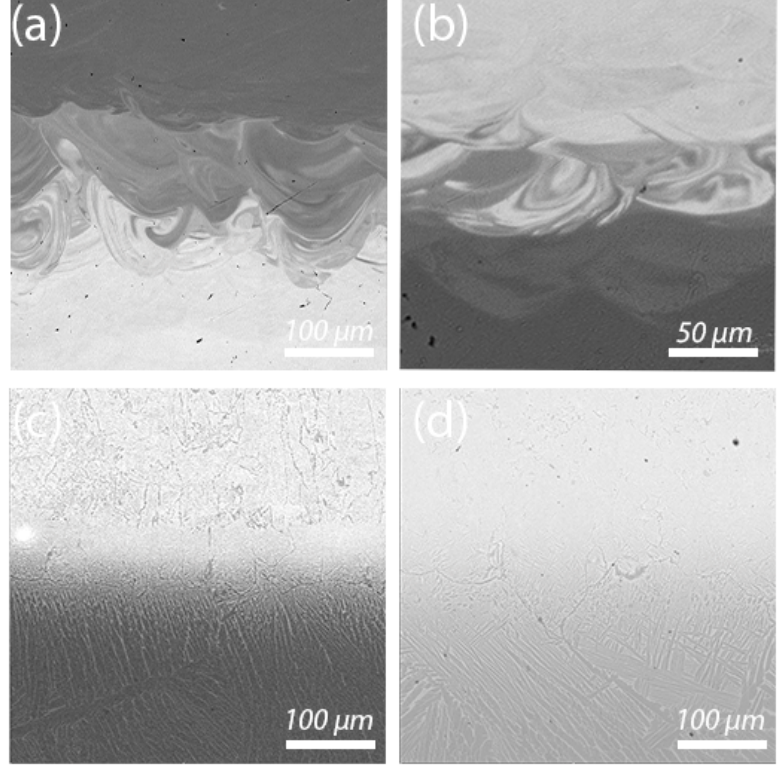
Figure 7. BSE-SEM images showing microstructures of the bimetallic samples: ( a ) fabricated without platform preheating (Type A), ( b ) fabricated with platform preheating (Type B), ( c ) Type B after annealing, ( d ) Type B after HIP.